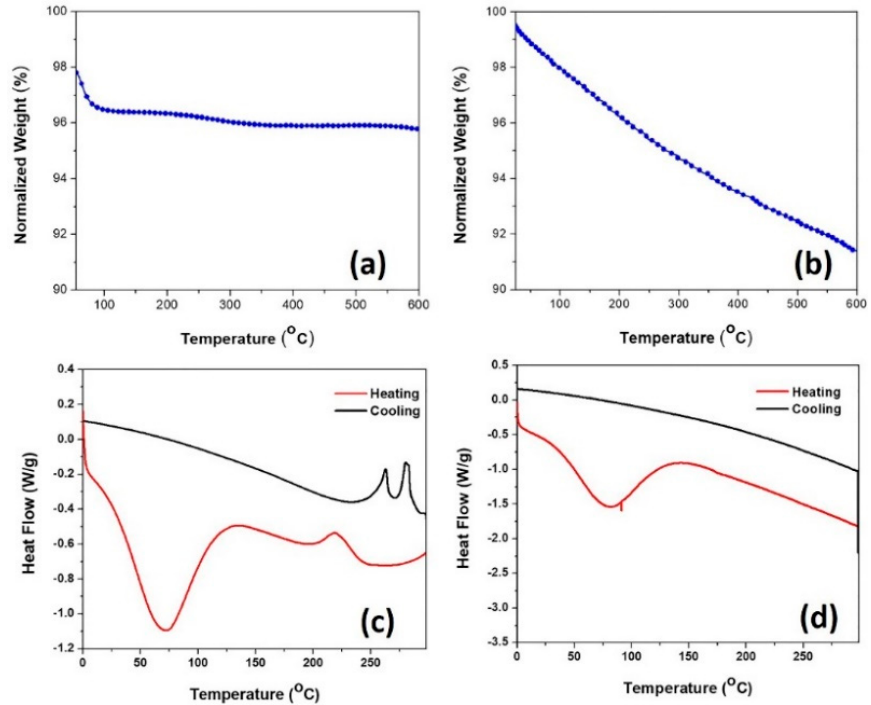
Figure 5. ( a ) and ( c ) Thermal gravimetric analysis-differential scanning calorimetry (TGA-DSC) of Pd/SiO 2 aerogel catalysts heated in the air atmosphere, ( b ) and ( d ) TGA-DSC of Pd/SiO 2 aerogel catalysts heated in the N 2 atmosphere.